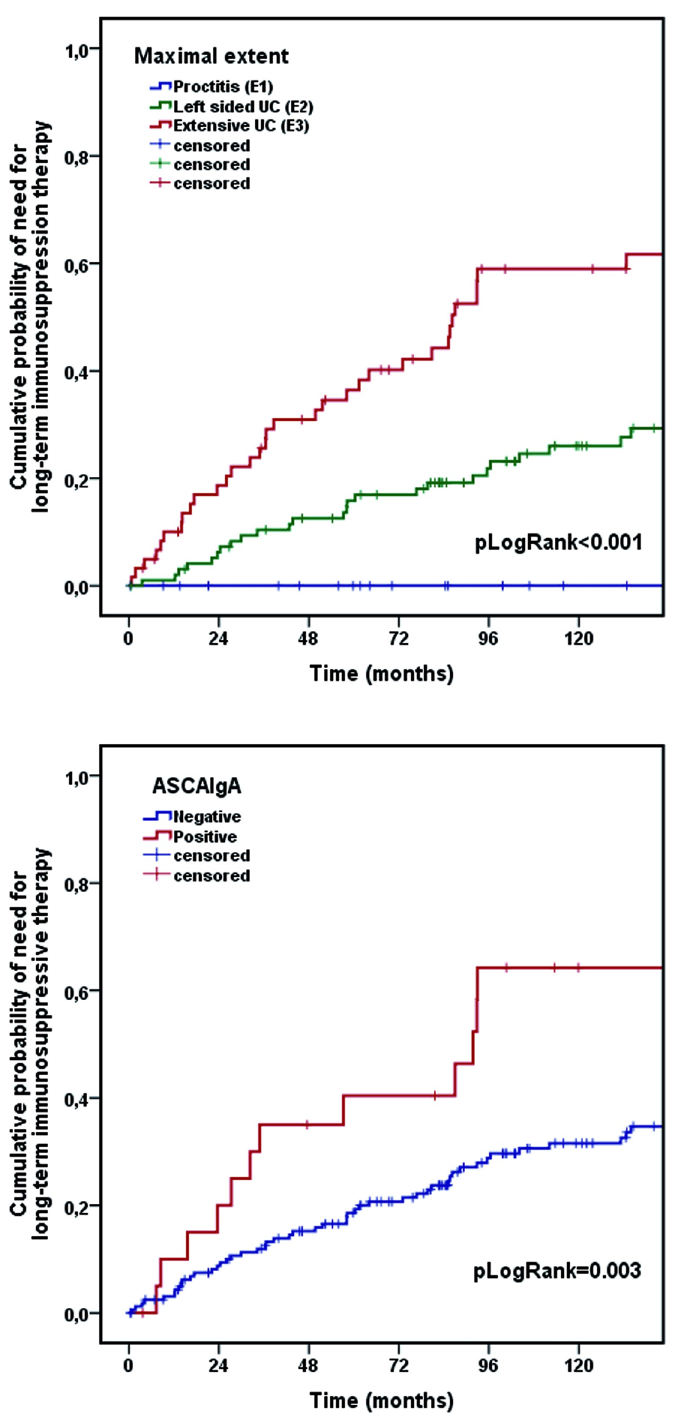
Fig 1. Kaplan–Meier survival plot of need for long-term immunosuppressant therapy with azathioprine in ulcerative colitis during follow-up.